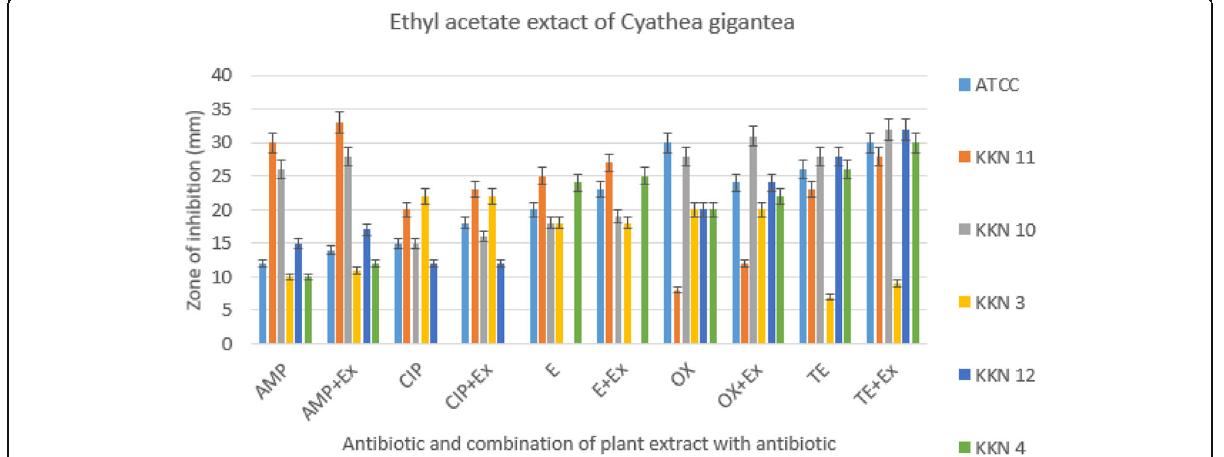
Fig. 1 Synergistic activity with the ethyl acetate crude extract against methicillin resistant Staphylococcus aureus